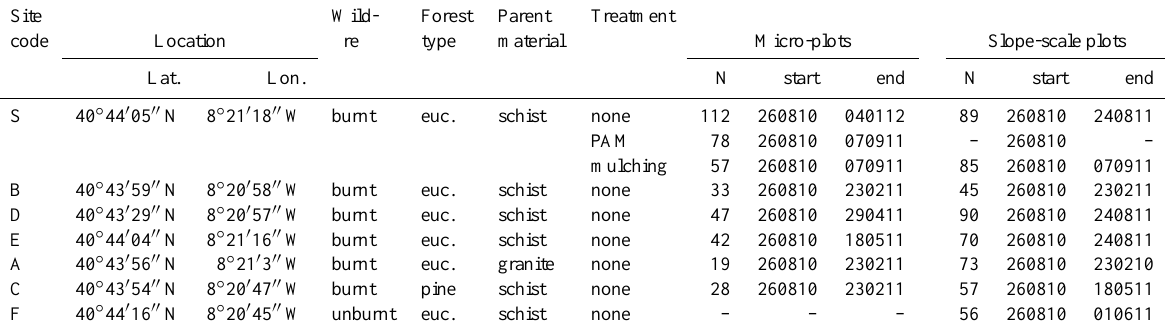
Table 1. General information about the seven study sites as well as the numbers of runoff samples from micro-plots and slope-scale plots analysed from each site and the start and end dates of collecting these samples (in ddmmyy). Site Wild- Forest Parent Treatment code Location fire type material Micro-plots Slope-scale plots